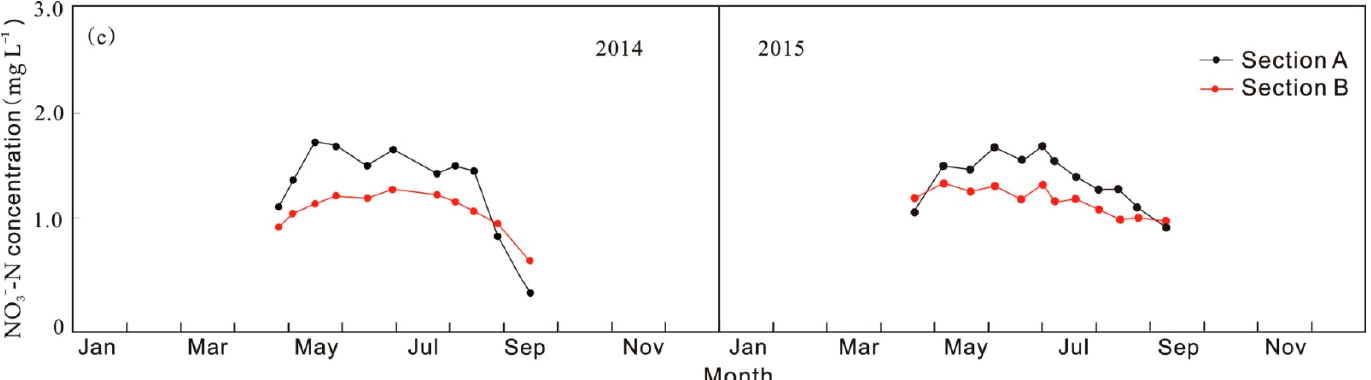
Figure 5. (a) Rainfall and irrigation events (i.e., R 1 , R 2 and R 3 ), flow rates per unit width, and (b) NH 4+ -N and (c) NO 3 − -N concentrations of the subsurface lateral flow in the rock at Sections A and B. Table 2. Comparison of NH 4+ -N and NO 3 − -N mass seepage flux per area (kg/s/km 2 ) during the highland barley growing periods. Sowing and Tilling Stages Jointing and Heading Stages Flowering and Filling Chemical